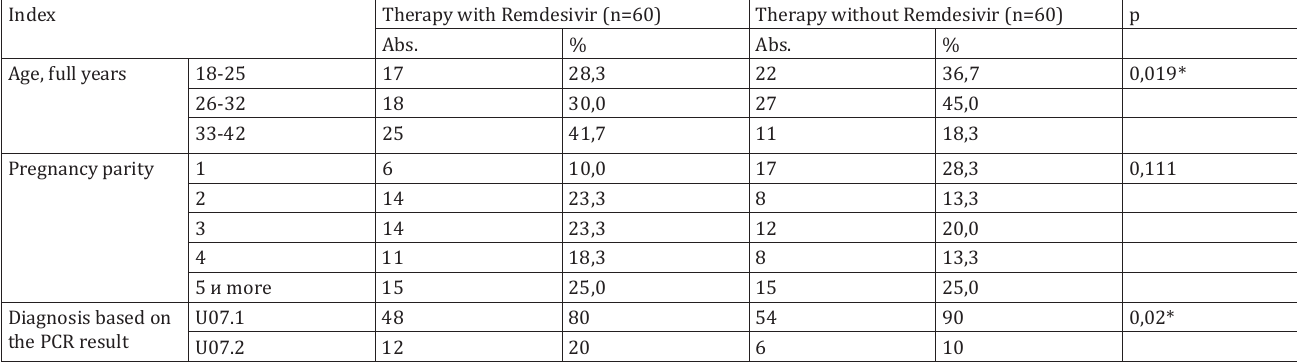
Comparative table of age, gestation parity among pregnant women with COVID-19, confirmed and probable Table 1 cases